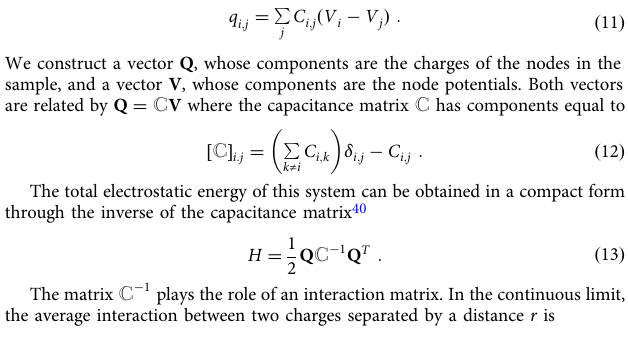
Table 1 Characteristics of the different a-NbSi samples: composition x , thickness d , low temperature sheet